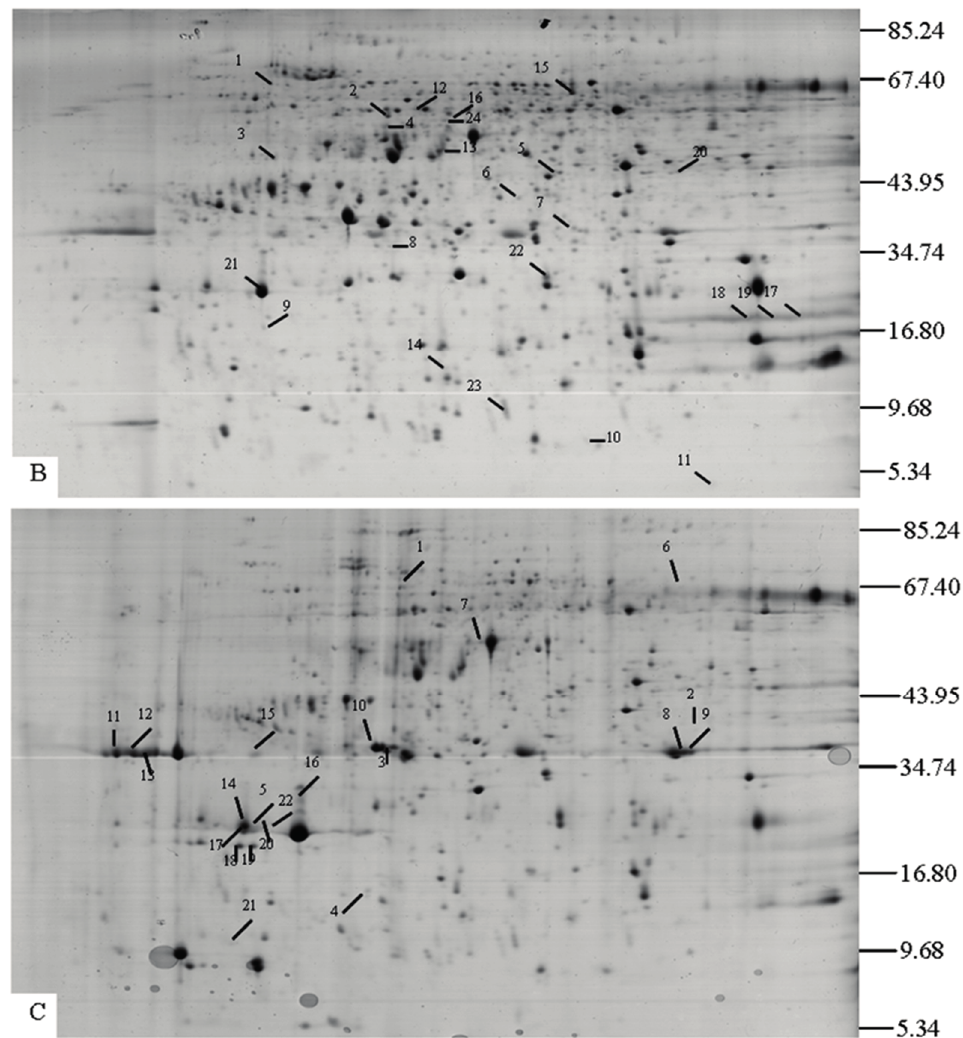
Figure 2. Protein spots expressed differentially and specifically from different explants of Fraxinus mandshurica . ( A ) Non-brown explant without SE, 1–23 show proteins specifically expressed in A, 24–30 show differentially expressed proteins between A and C (24 and 25 were up-regulated in A and 26–30 were down-regulated in A); ( B ) Browned explant with SE, 1–15 show specifically expressed proteins in B, 16–19 show differentially expressed proteins between B and C (16 and 19 were up-regulated in B and 17 and 18 were down-regulated in B), 20–24 show differentially expressed proteins between B and A (20–22 were up-regulated in B and 23–24 were down-regulated in B); ( C ) Browned explant without SE, 1–7, 10–16 and 20–21 show specially expressed proteins in C, 8 and 9, 17–19 and 22 show specially expressed proteins in browned explants (B and C), which were up-regulated in